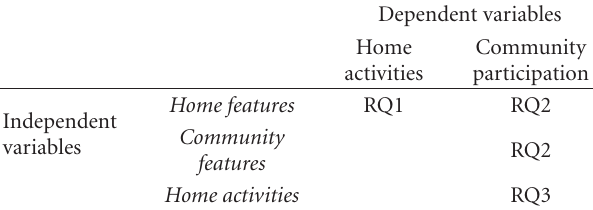
Table 1: Research